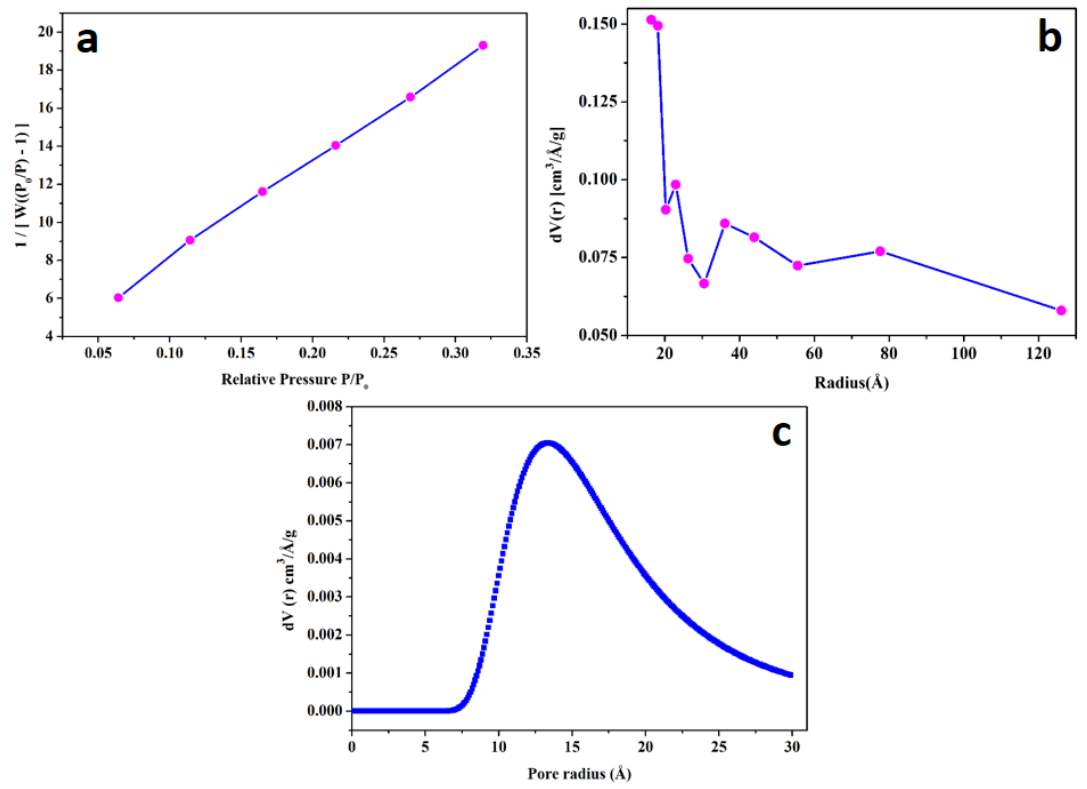
Figure 3. ( a ) BET, ( b ) BJH and ( c ) DA pore radius plots of ruthenium oxide